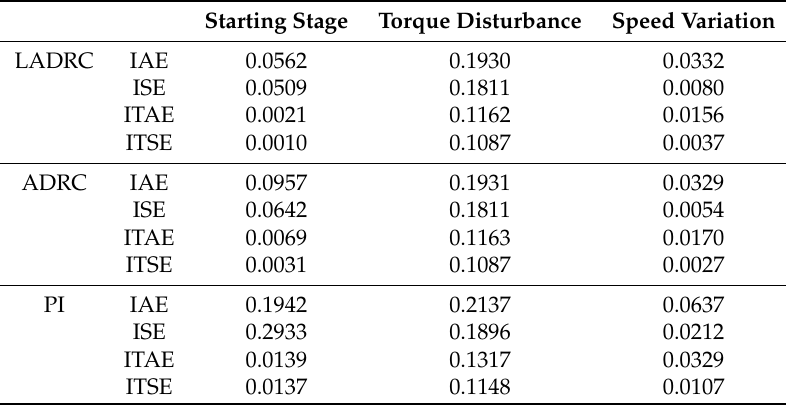
Table 5. Performance indices of i qs in different operating